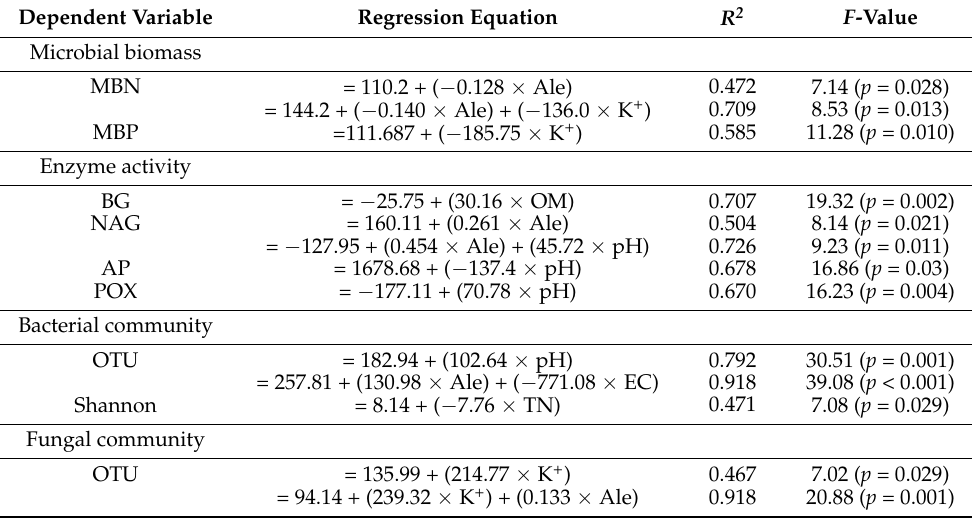
Table 4. Stepwise multiple regression analysis of soil microbial biomass, extracellular enzyme activity, microbial community index, and selected soil parameters from nonmetric multidimensional scaling (NMDS).